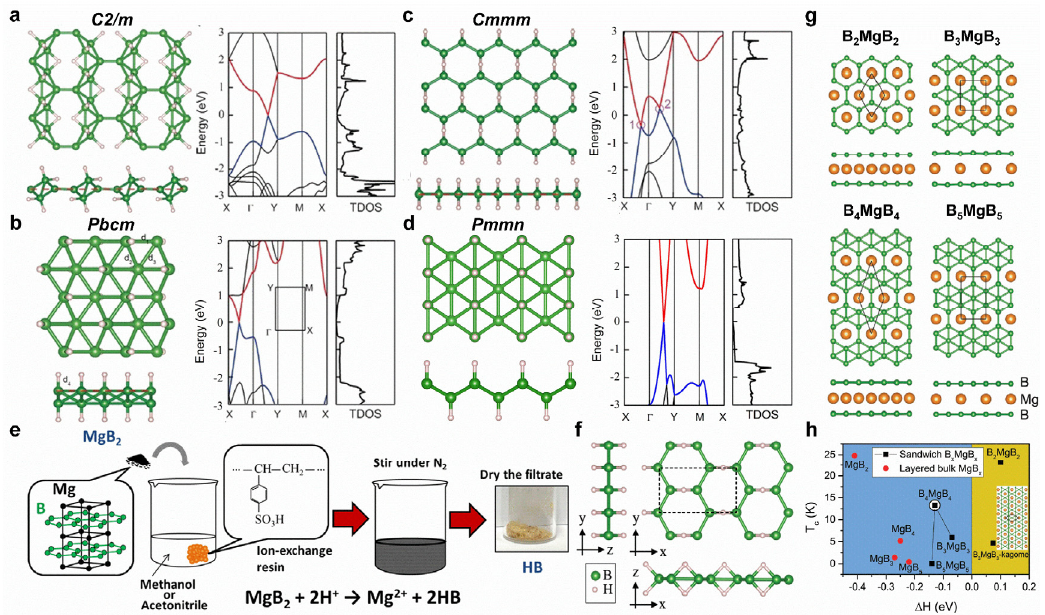
Figure 4. Surface modifications of borophene. ( a – d ) Top and side views as well as calculated band structures of ( a ) C2/m , ( b ) Pbcm , ( c ) Cmmm , and ( d ) Pmmn BH structures. The red and blue lines represent the unoccupied and occupied band dispersions near Fermi level, respectively. ( e ) Synthesis process of BH sheets. ( f ) Proposed structure model of synthesized BH sheet. ( g ) Top and side views of 2D sandwich structures of B 2 MgB 2 , B 3 MgB 3 , B 4 MgB 4 , and B 5 MgB 5 . ( h ) Calculated T c as a function of the formation enthalpy. ( a – d ) Reprinted with permission from Ref. [107]. Copyright 2016, Wiley. ( e , f ) Reprinted with permission from Ref. [108]. Copyright 2017, American Chemical Society. ( g , h ) Reprinted with permission from Ref. [102]. Copyright 2017, Royal Society of Chemistry.